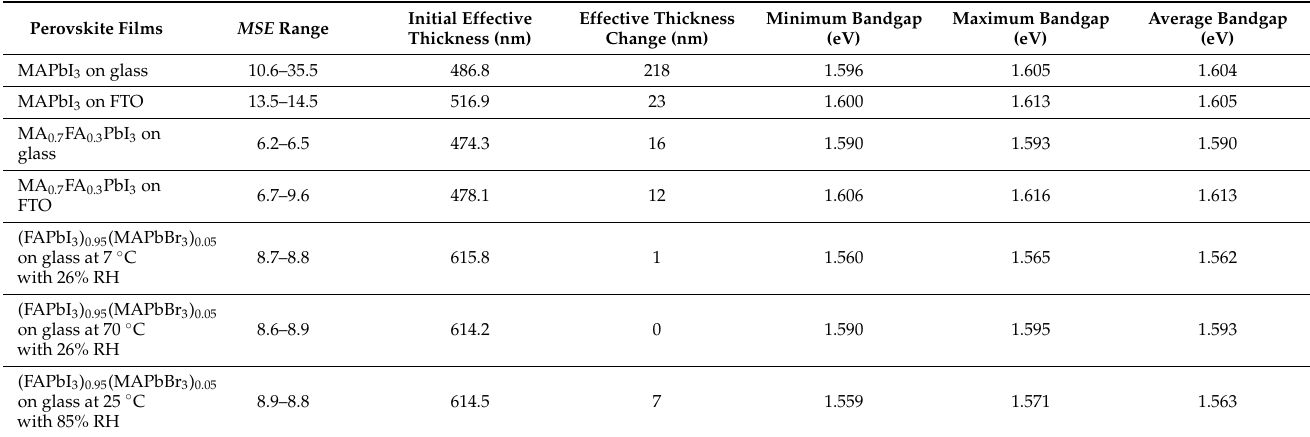
Table 1. MSE range; initial effective thickness; effective thickness change; and minimum, maximum, and average bandgap values for perovskites films over 0 to 550 min of exposure time as obtained from time dependent fitting of spectra in ε . Perovskite